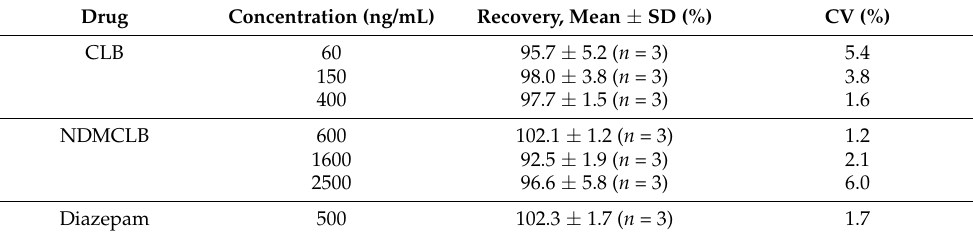
Table 3. Mean percent recovery for clobazam (CLB) and N -desmethylclobazam